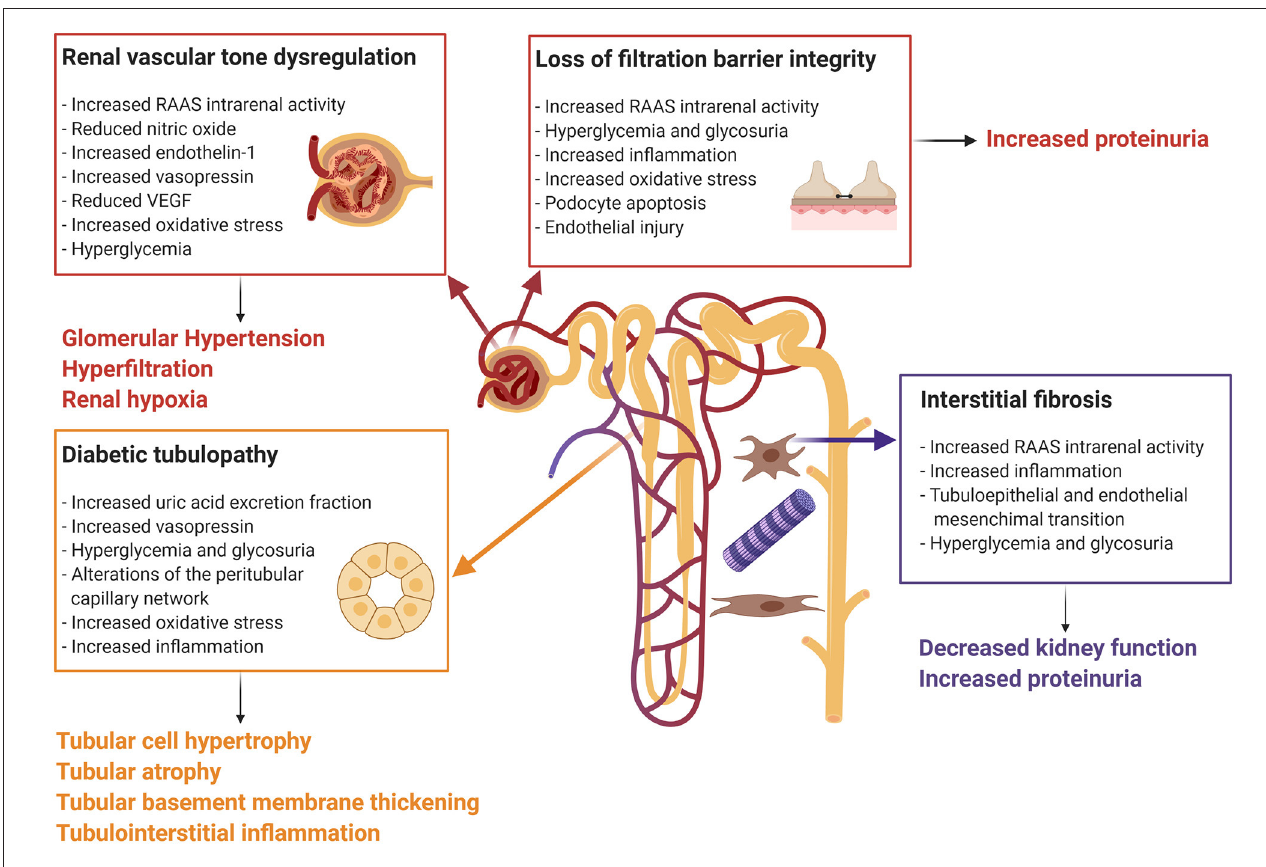
FIGURE 1 | Mechanisms of diabetes-induced kidney injury. Every box represents one mechanism of diabetes-associated kidney injury with the respective causes. Connected to each box the clinical effect of the pathophysiologic pathway. The Figure was created with BioRender.com. RAAS, renin-angiotensin-aldosterone system; VEGF, vascular endothelial growth